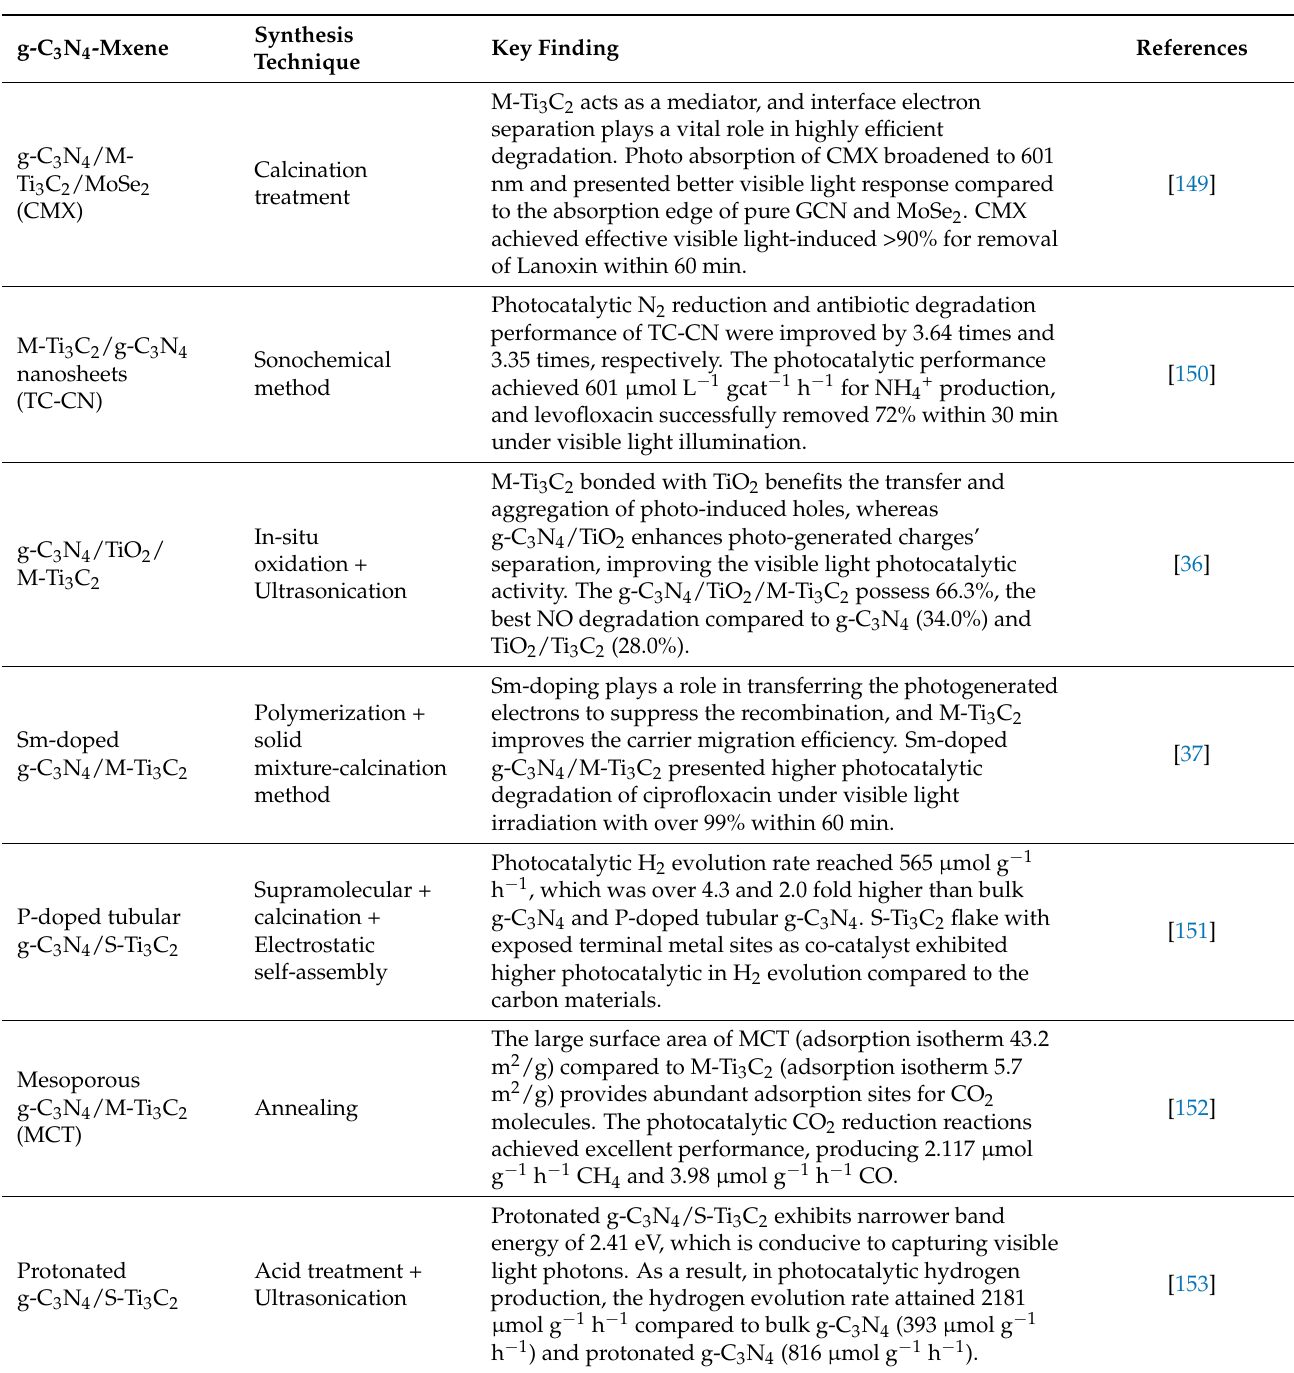
Table 6. Summary of g-C 3 N 4 -Mxene based photocatalysts synthesis